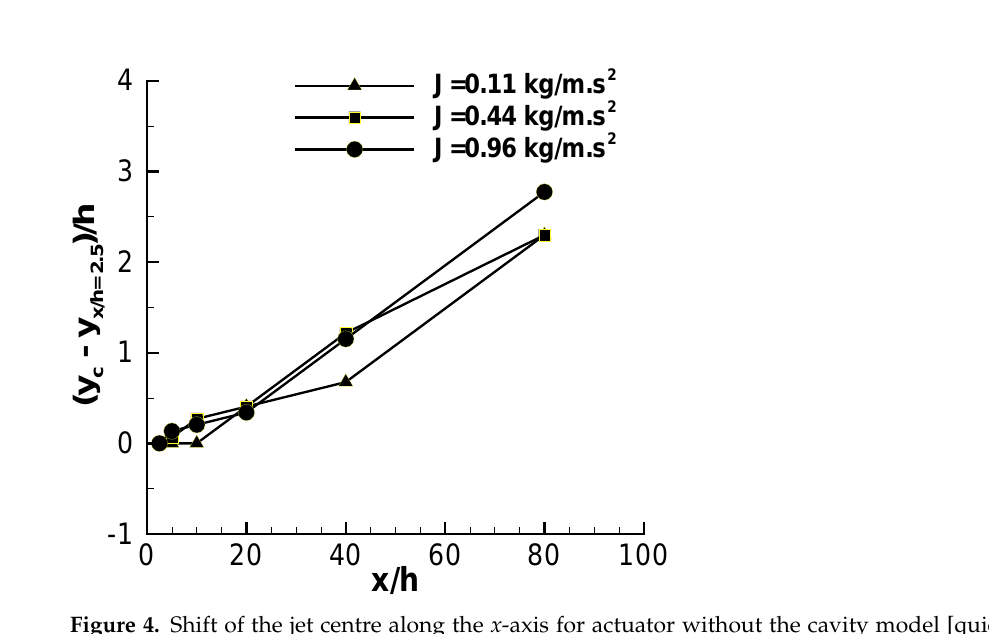
Figure 4. Shift of the jet centre along the x -axis for actuator without the cavity model [quiescent condition] with different J values.